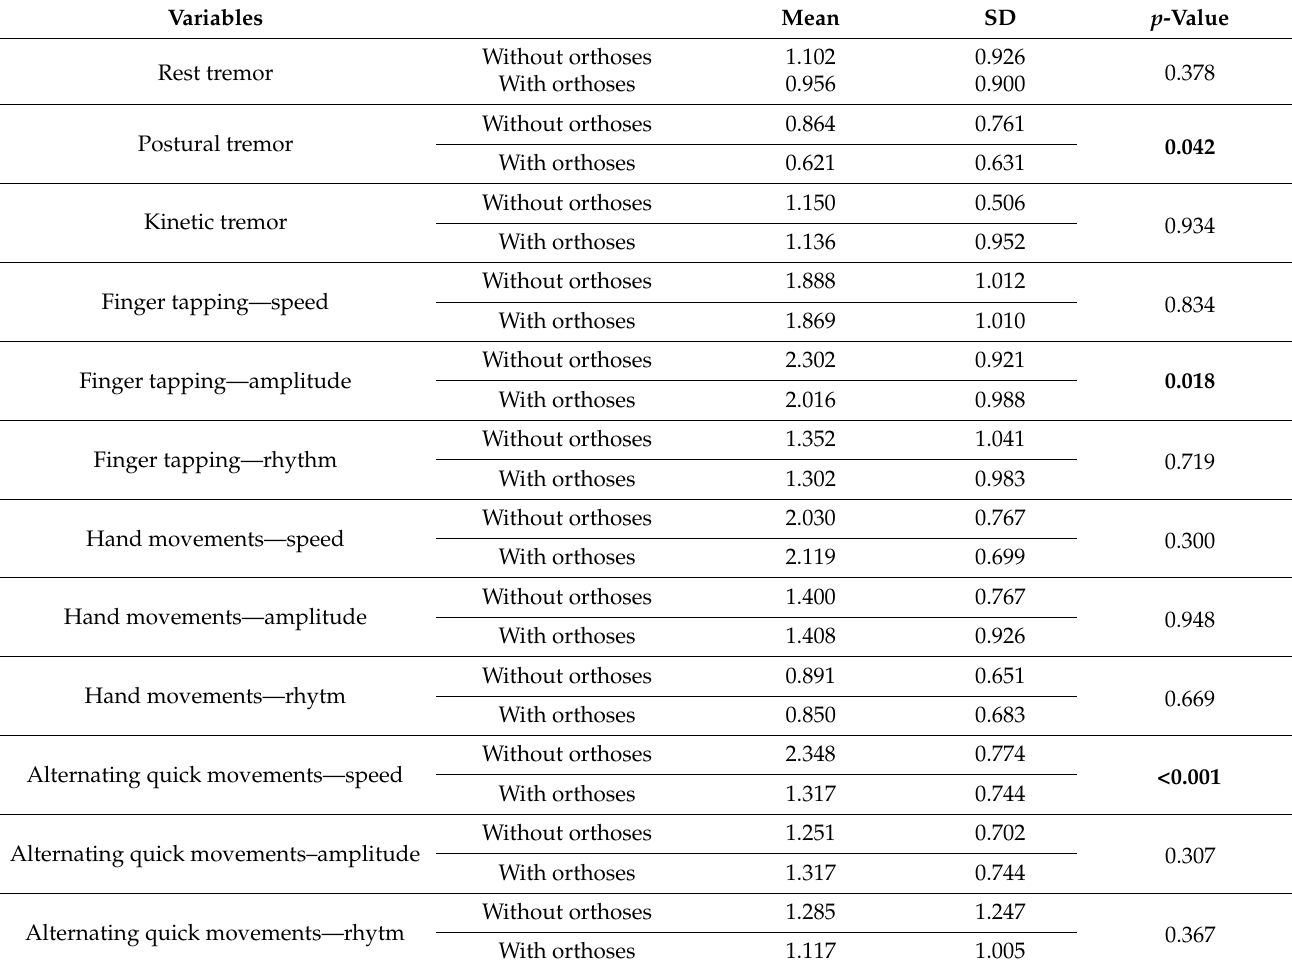
Table 3. Kinessia OFF state, with and without orthoses—baseline assessment ( n =